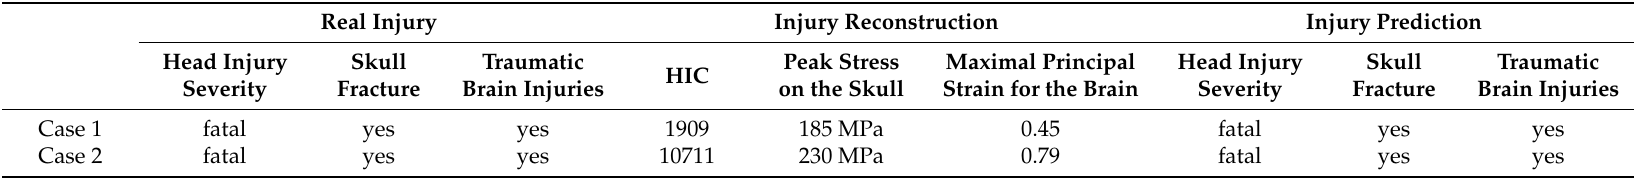
Table 4. Injury reconstruction and prediction results of